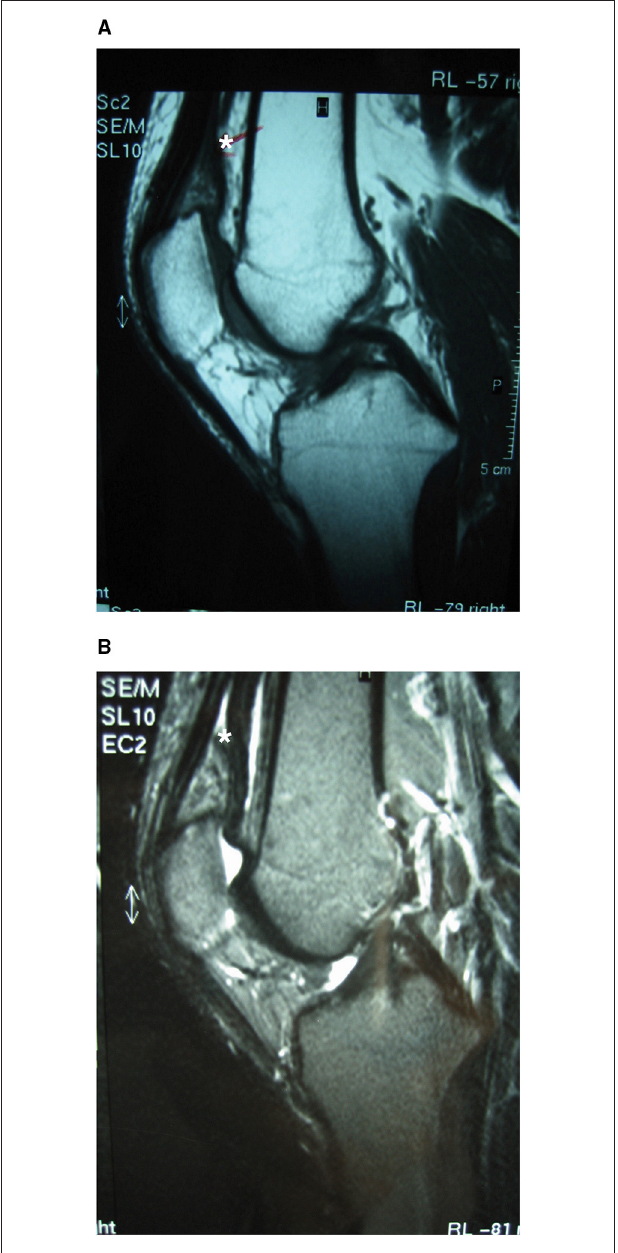
FIGURE 5 | Case 3: suprapatellar SH MRI. MR sagittal images showing an intra-articular synovial mass located superior and medial to the patella that eroded the superior patellar cortical bone; the mass was heterogeneously hypointense on T1-weighted imaging (A) and isointense on T2-weighted imaging (B) . *Location of the Synovial Haemangioma tumor in the knee.